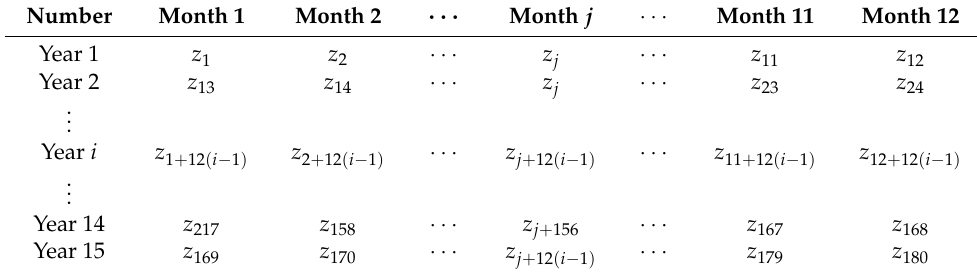
Table 2. The yearly container throughput expressed by a functional